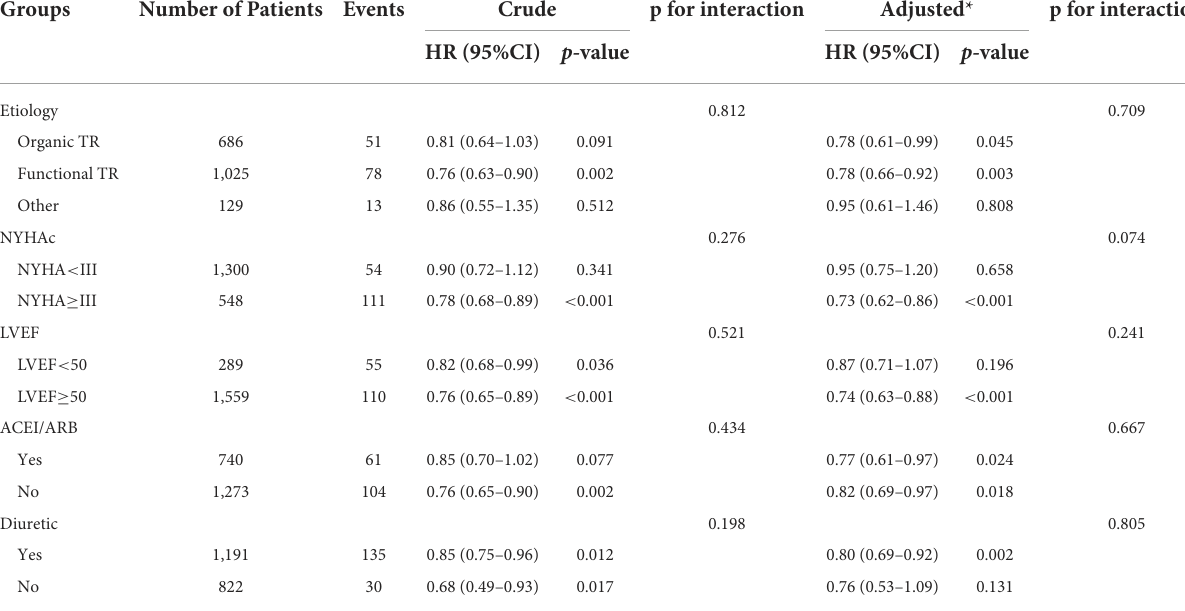
TABLE 5 Subgroup analyses of DBP in Clinically Meaningful